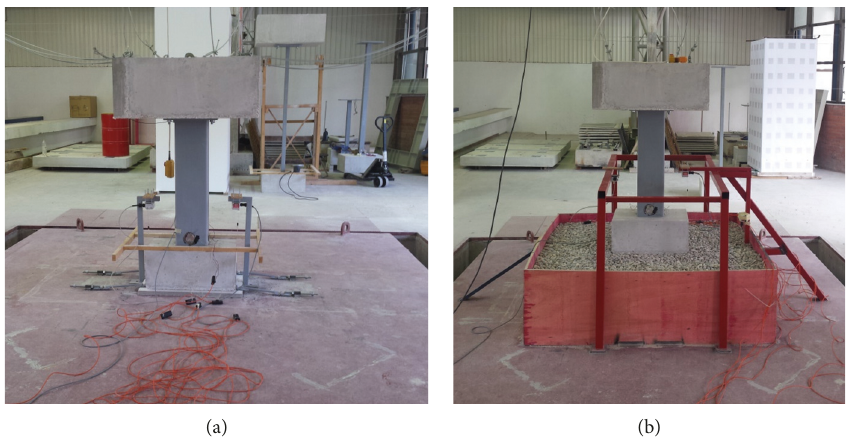
Figure 9: Photos of experimental setup before testing. (a) MSB on rigid base. (b) MSB on layer P